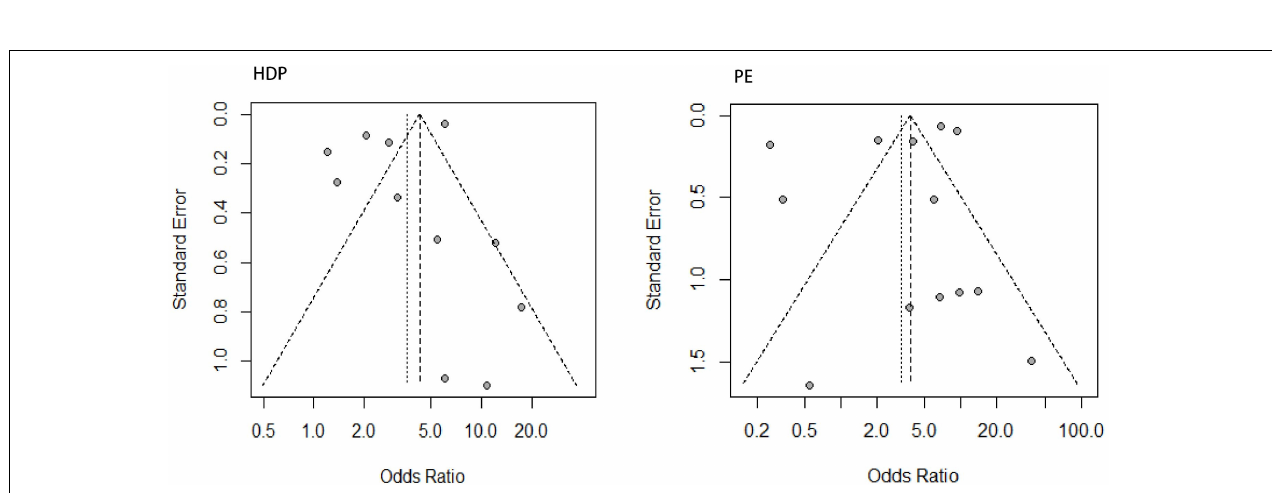
FIGURE 4 | Funnel plot of the included studies for the HDP and PE